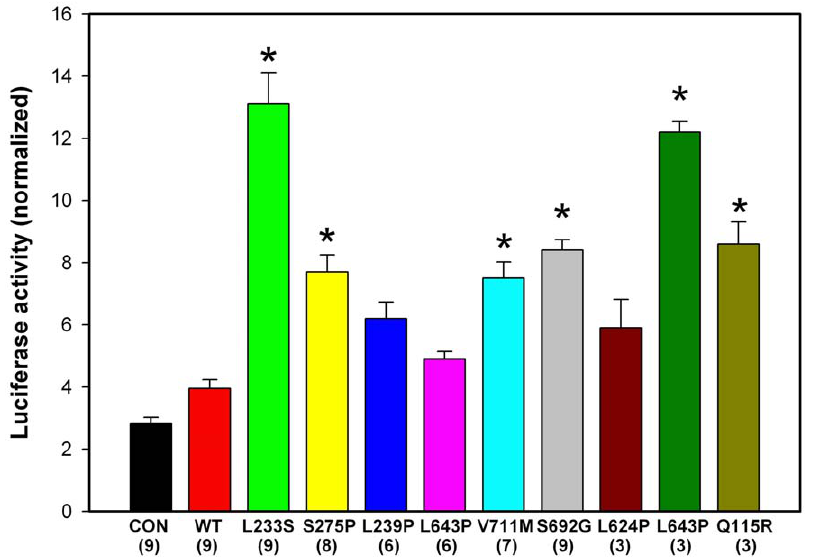
Figure 1. GGAP2 mutations result in enhanced transcription from AP-1 reporter constructs. Asterisks indicate statistically significant increase relative to wild-type (WT) GGAP2 by ANOVA (p , .05). Mean + / 2 SEM. Mutation and number of transfections are shown.